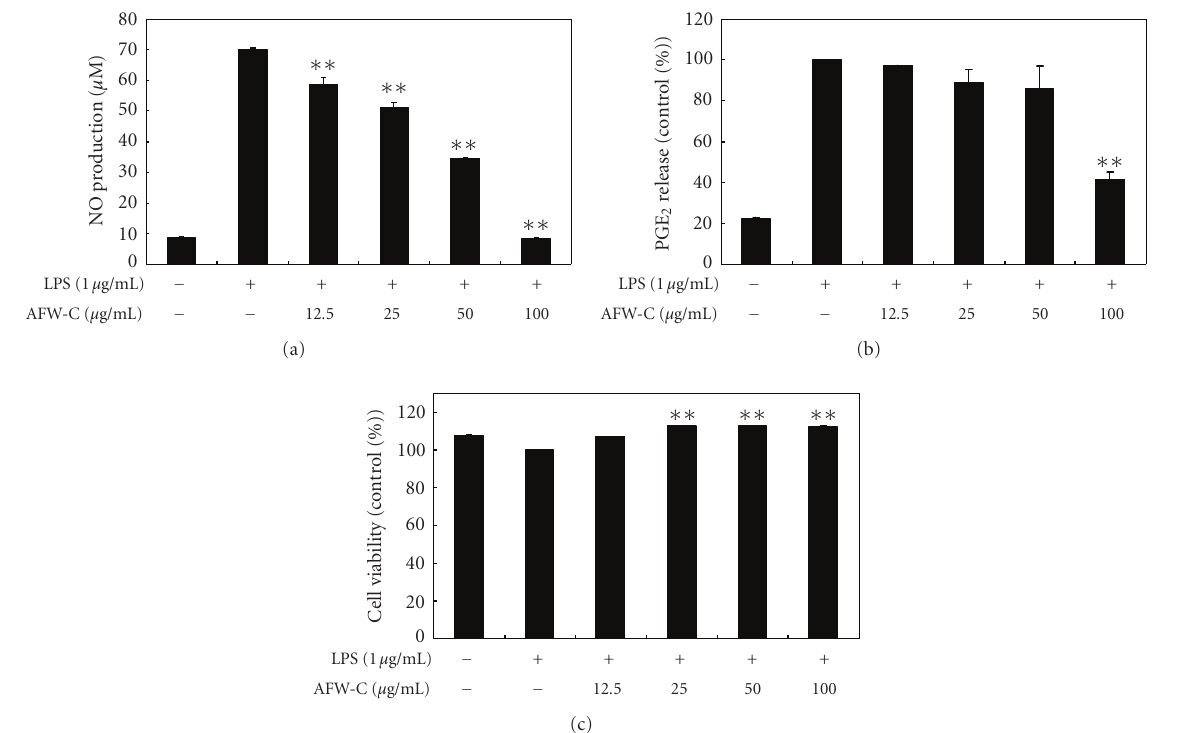
Figure 4: E ff ect of CH 2 Cl 2 fractions from A. koreanum fruit waste on nitric oxide (a) and PGE 2 (b) production in RAW 264.7 cells. E ff ects of CH 2 Cl 2 fractions from A. koreanum fruit waste on nitric oxide production in RAW 264.7 cells were determined from the 24-hr culture of cells stimulated with LPS (1 μ g/mL) in the presence of CH 2 Cl 2 fractions. Nitric oxide production was determined by the Griess reagent method. PGE 2 released into the culture medium was assayed by ELISA. The data represent the mean ± SD of triplicate experiments. Values are the mean ± SEM of triplicate experiments. ∗ P < . 05; ∗∗ P < . 01.